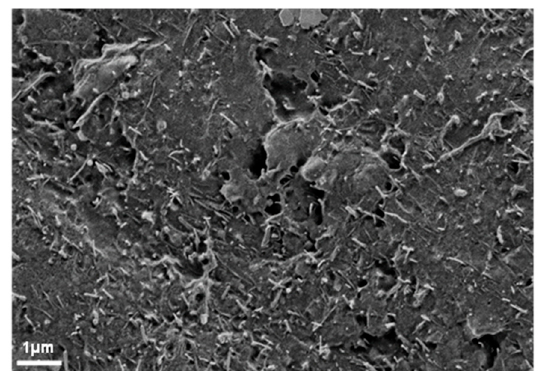
Figure 6. SEM image of the cross section of a composite Ep / MWCNT-10% (representative for all specimens).